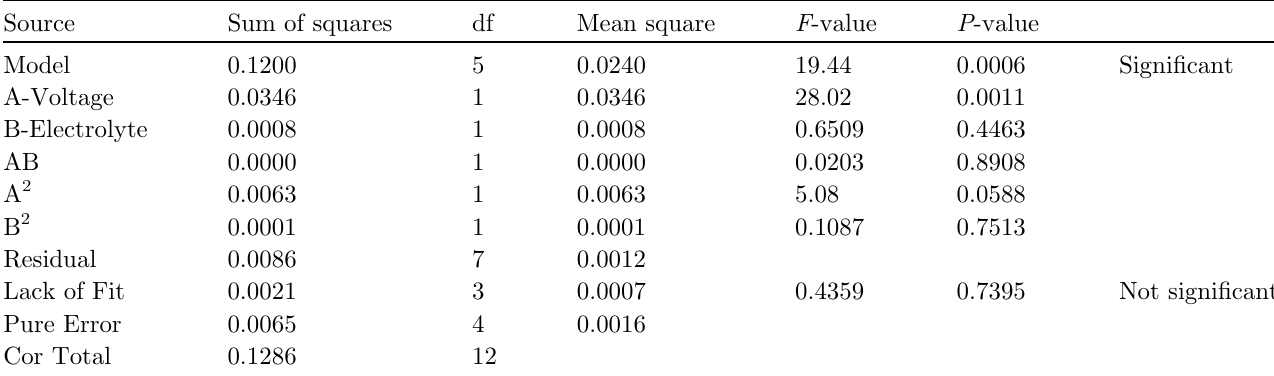
Table 3. ANOVA for outer diameter.